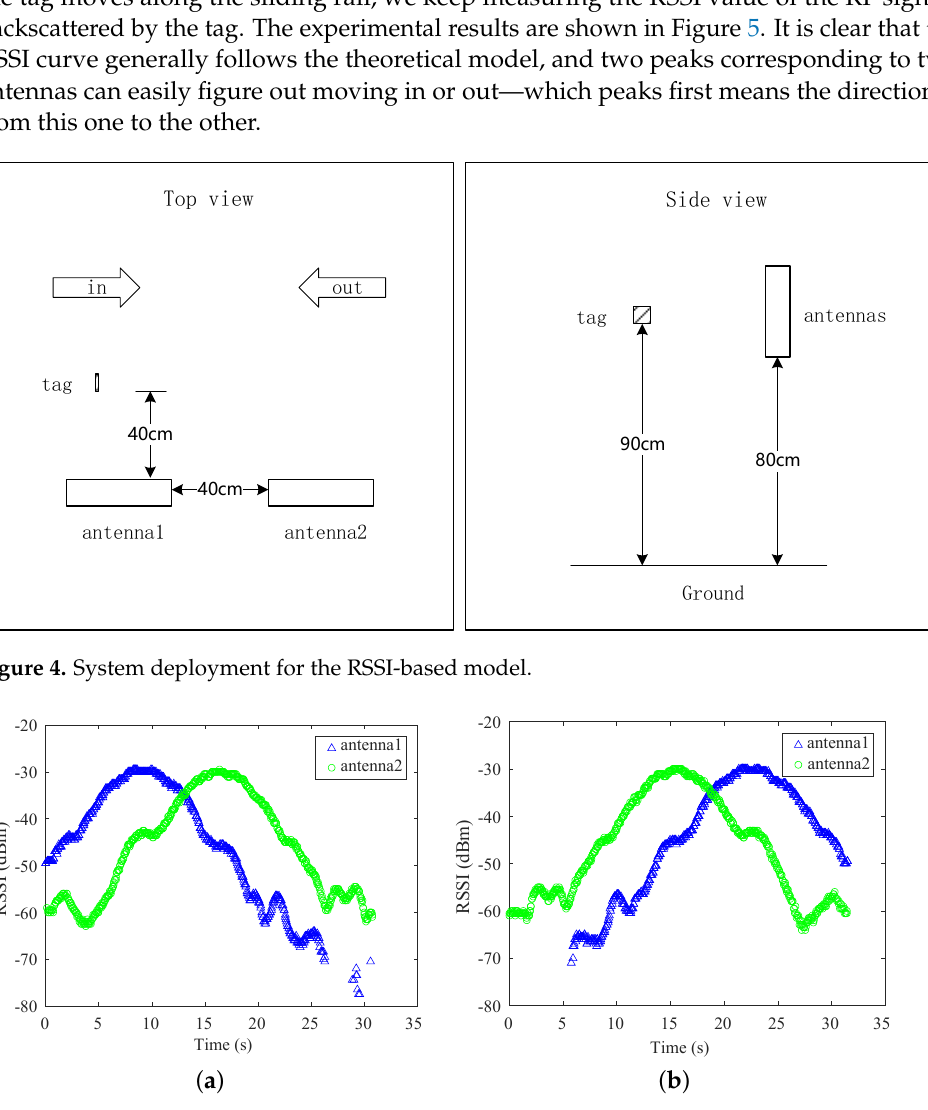
Figure 5. RSSI values with respect to the time; ( a ) moving in; ( b ) moving